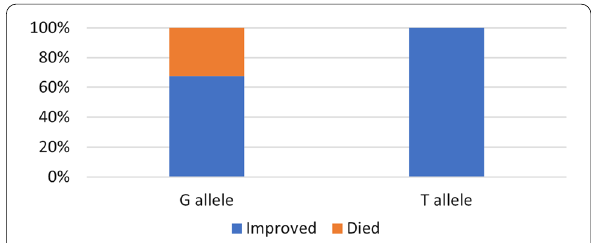
Fig. 2 Association of ACE2 SNP with the disease